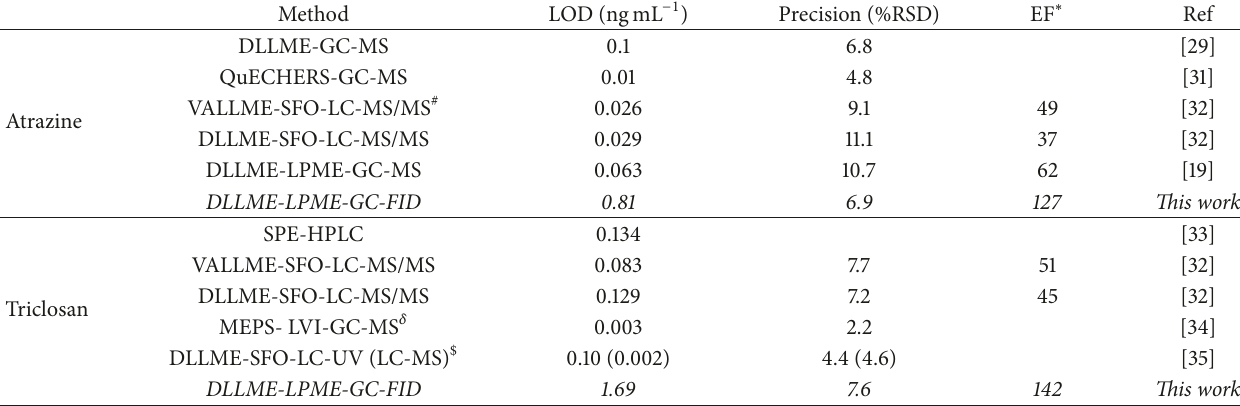
Table 2: Comparison of some analytical parameters for this method with those reported in literature for the same analytes.